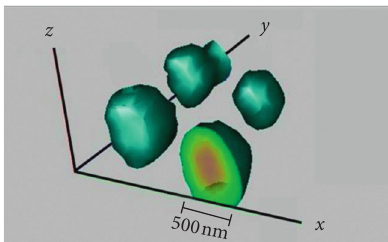
Figure 6: 3D image of two dimensionally arranged PE-dye-doped polystyrene nanoparticles with DFWM confocal